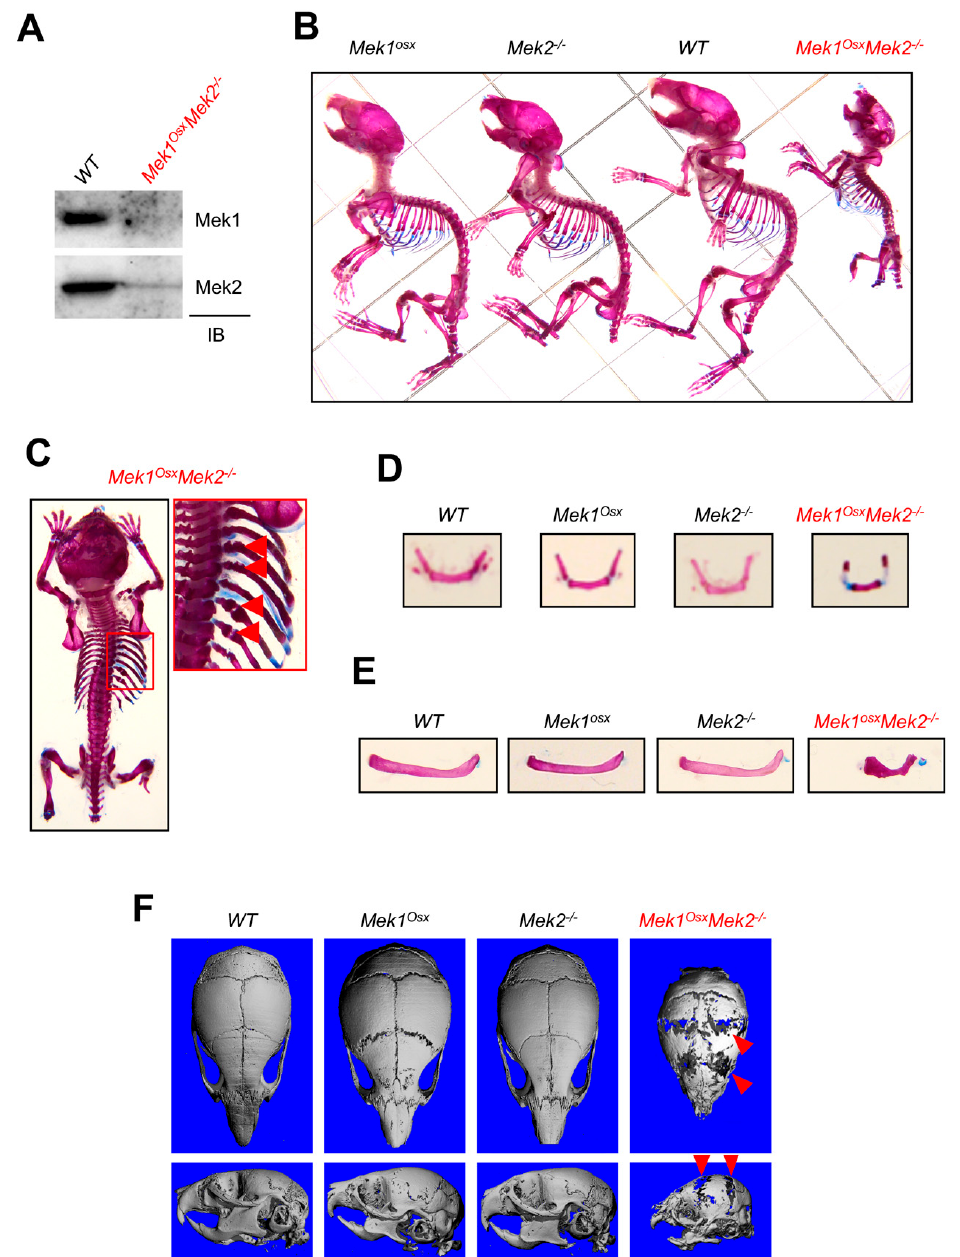
(Figure 5B), suggesting that ERK-mediated mechanisms independent of GSK3 β phosphorylation are responsible for β -catenin stability in osteoblasts. These results are consistent with luciferase assays showing that the transcriptional activities of RUNX2 (OG2-luc), β -catenin (TopFlash-luc), and ATF4 (OSE1-luc) were all markedly decreased in ∆ Mek1 / 2 COBs (Figure 5C). Thus, the ERK MAPK pathway Int. J. Mol. Sci. 2019 , 20 , x is critical for activation of RUNX2, β -catenin, and ATF4 in osteoblasts.